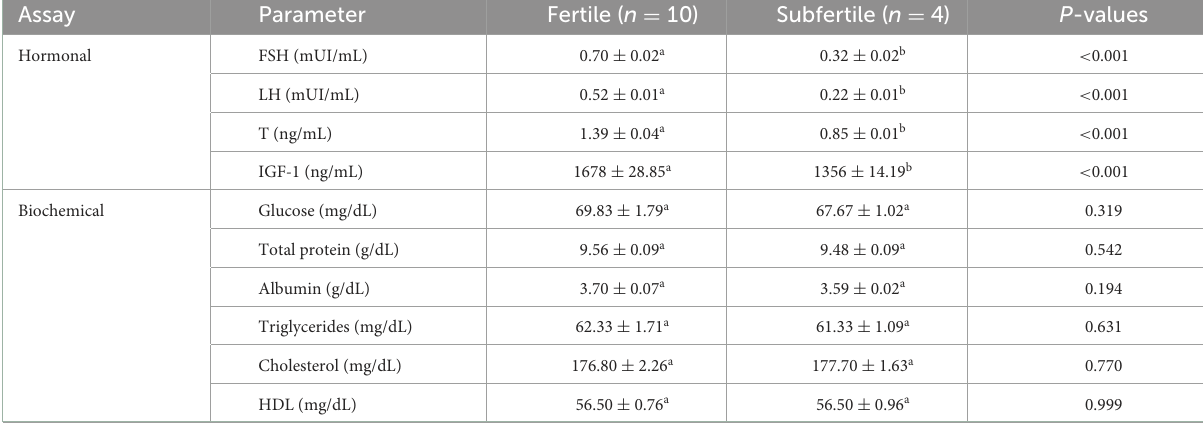
TABLE 3 Serum fertility biomarkers (mean ± SEM) of fertile and subfertile buffalo bulls. Assay